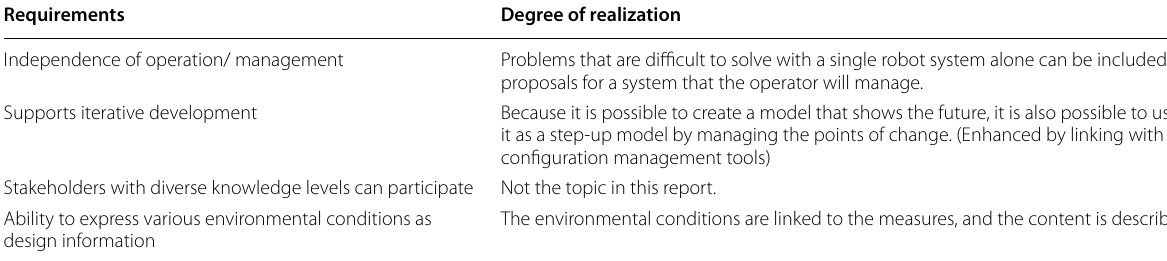
Table 5 Realization of the requirements for agricultural robots